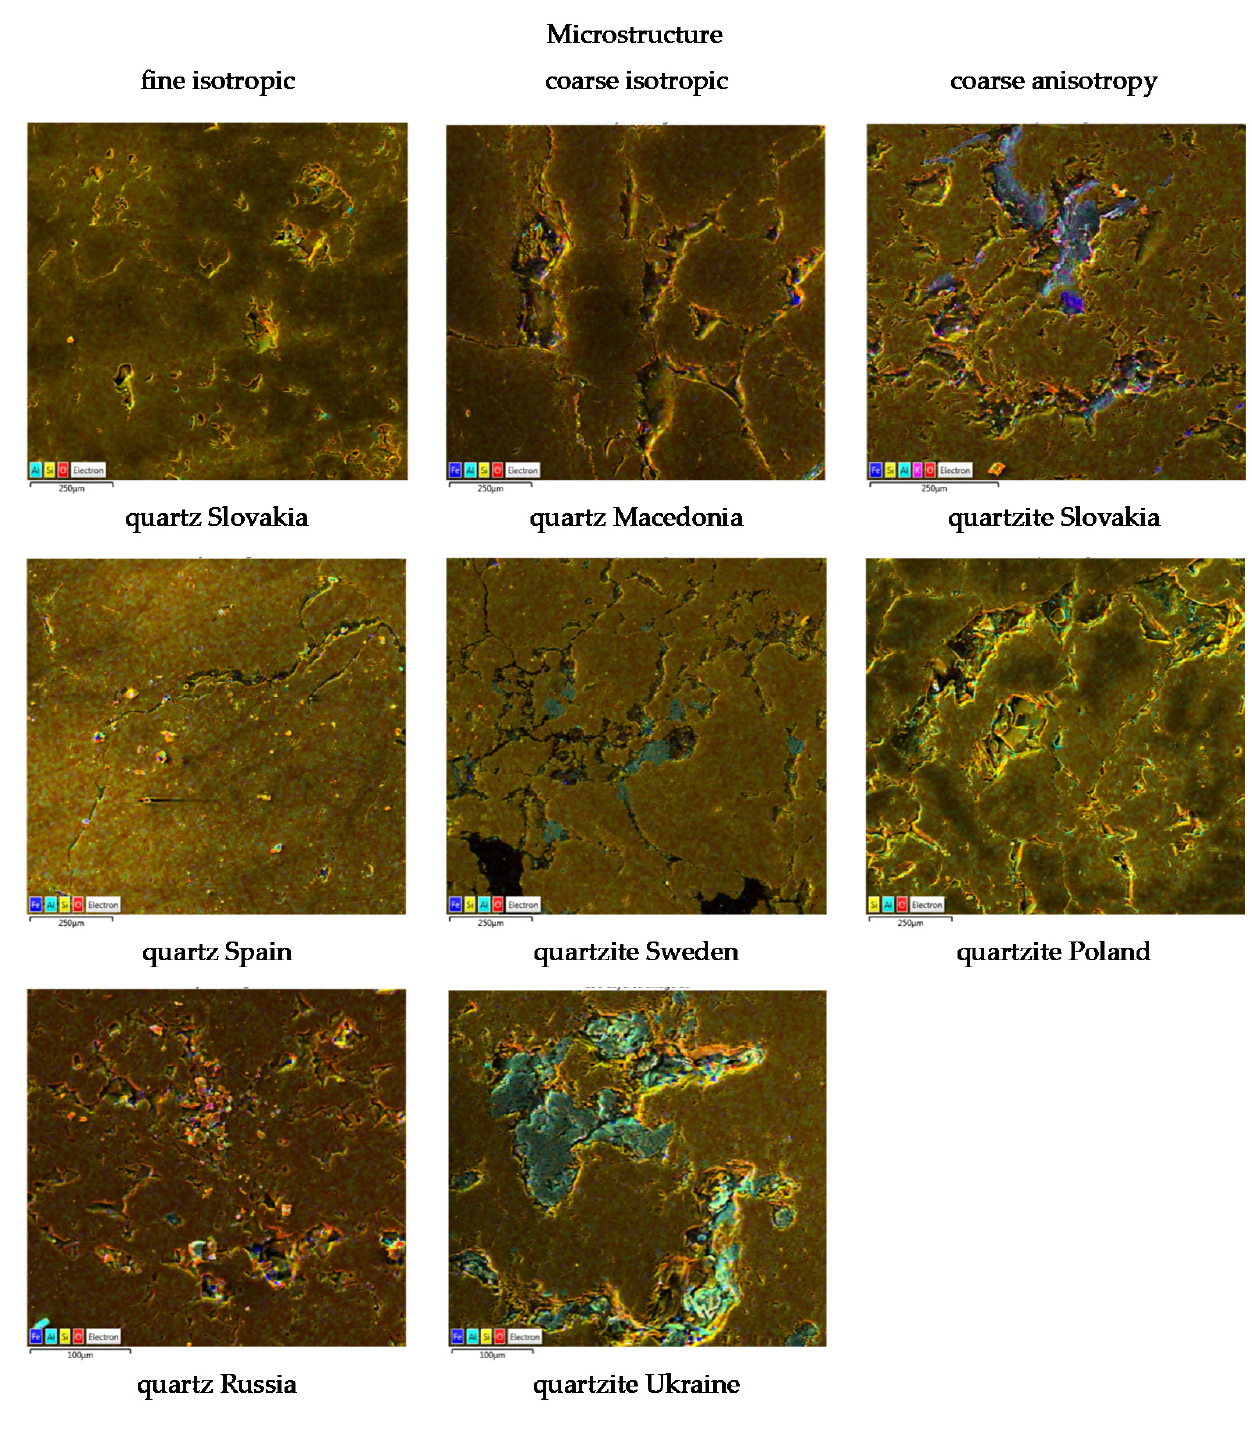
Figure 6. Microstructures of quartzes and quartzites.